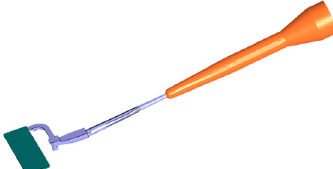
Figure 6. Model of the cavity (green), runner (purple) and screw (modelled as hot runner, indicated in orange).